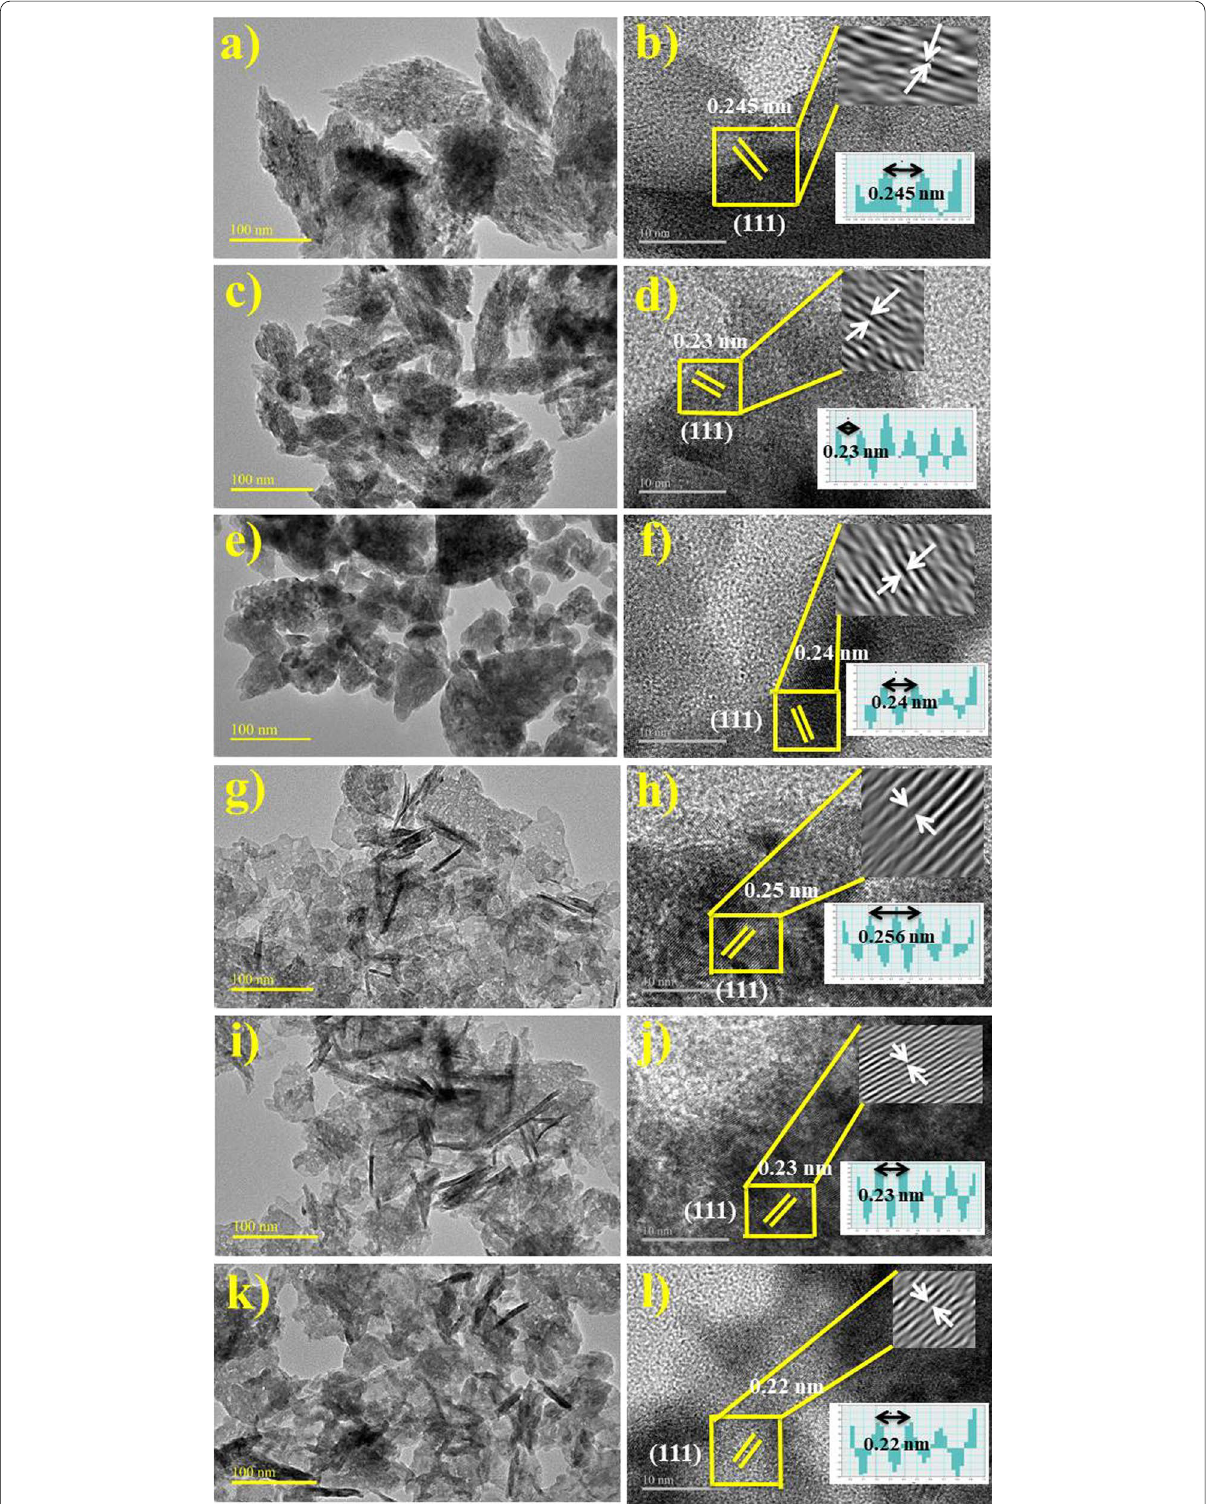
Fig. 7 a , b HR‑TEM, a – f lattice fringes of 3 mL, 6 mL and 12 mL ZO‑doped CuO g – l lattice fringes of 3 mL, 6 mL and 12 mL AS‑doped CuO NPs,